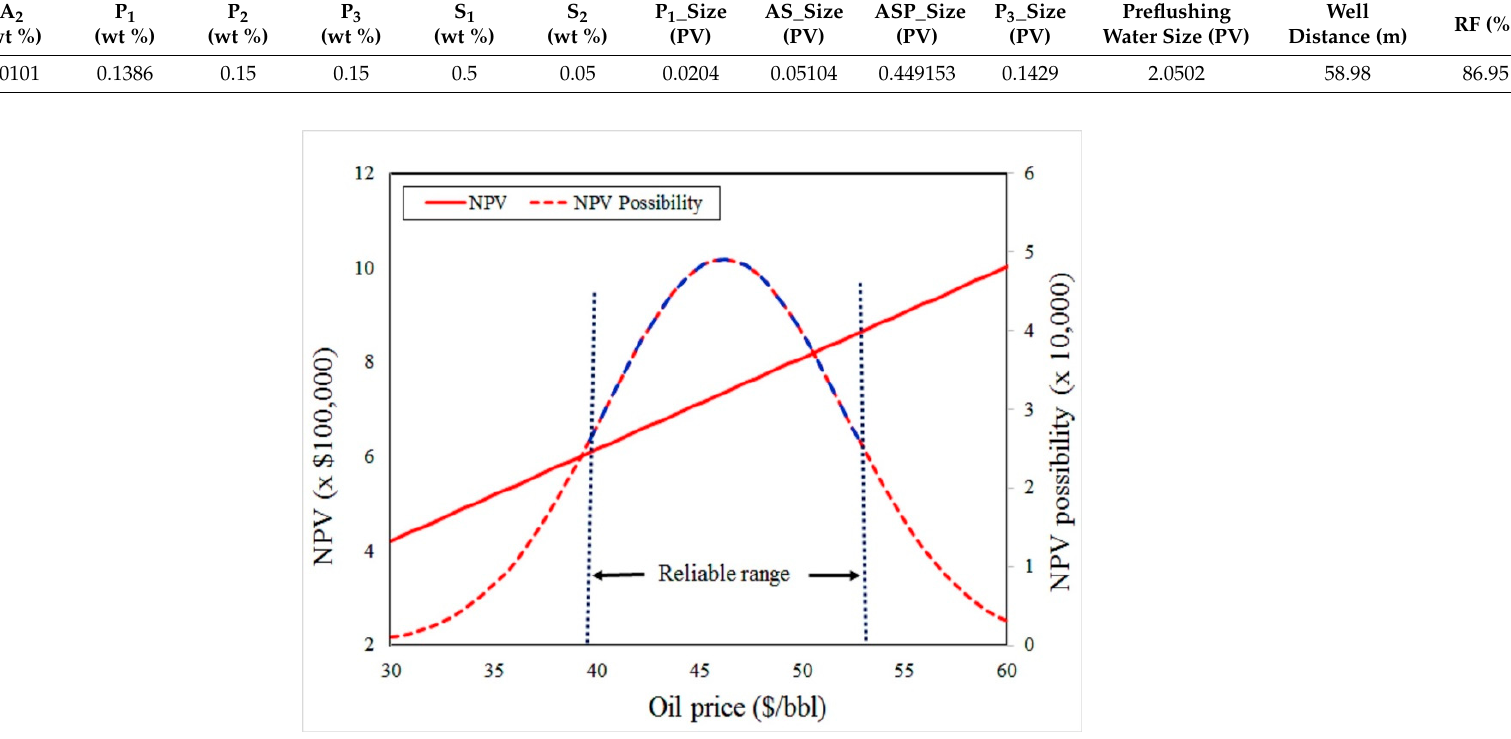
Figure 10. NPV and NPV possibility at various oil prices. As the oil price falls to reliable range which has possibility higher than half of the peak point, the project can achieve the profit from 0.61 $MM to 0.87 $MM Table 6. Optimal design of the 13 parameters for providing the maximal NPV.